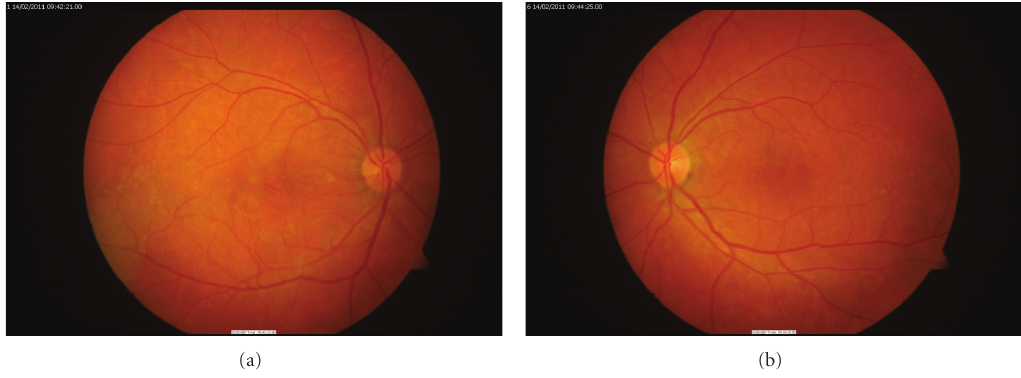
Figure 1: Fundus photographs at presentation.